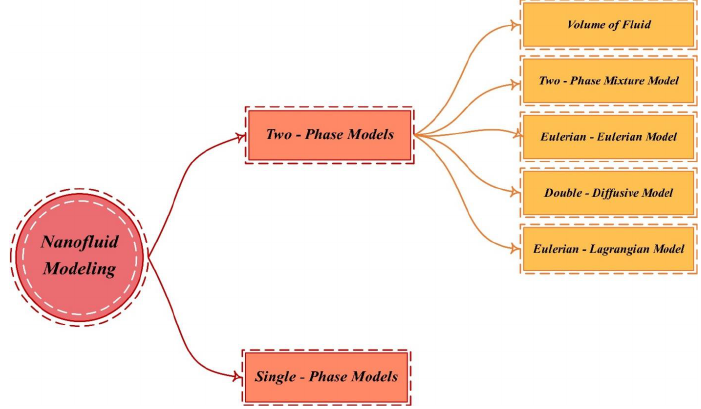
Figure 10. Simulation methods for nanofluids [60].